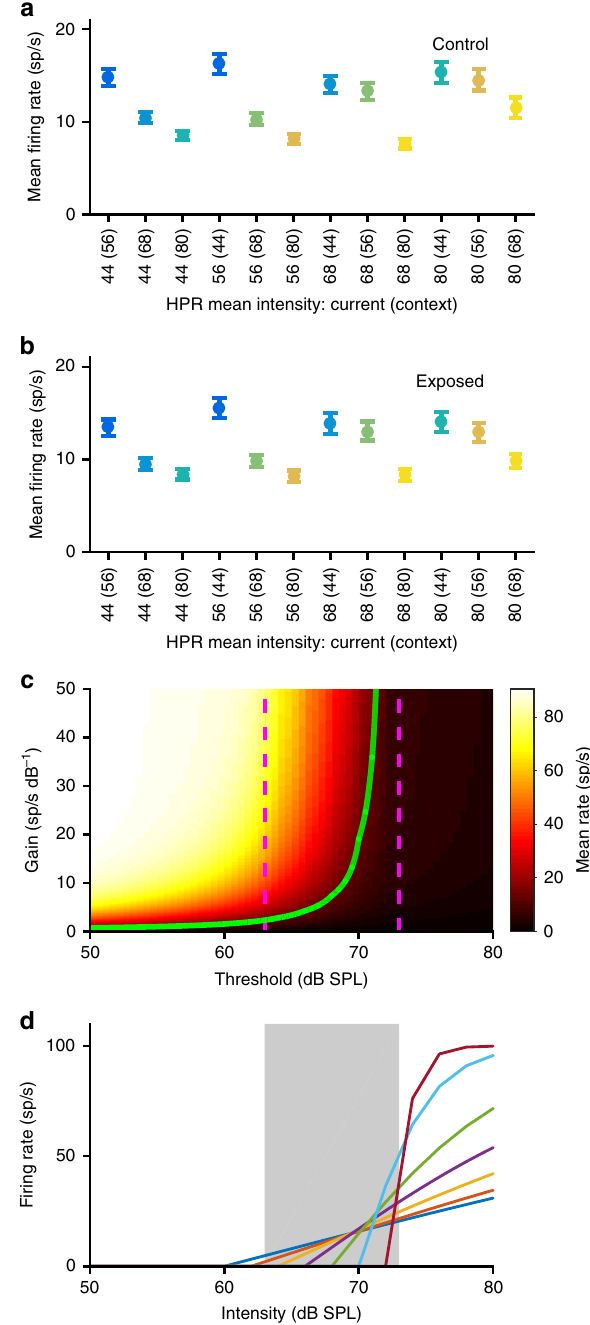
Fig. 5 Constant mean fi ring rates across HPRs and adaptation model. a Mean fi ring rates over the entire duration of each HPR, averaged across all MUCs from control animals. Colour scheme for the HPRs is the same as in Fig. 3. All error bars denote ±s.e.m. b Mean fi ring rates of MUCs from noise-exposed animals. c Mean fi ring rates of a model neuron for a 68 dB HPR stimulus, in dependence upon its RIF threshold and steepness. The magenta dashed lines indicate the intensity range of the HPR, and the green line denotes those combinations of RIF threshold and gain that give a mean rate of 10 sp/s. d Model RIFs with different thresholds, where the steepness of each RIF has been adjusted to yield a mean fi ring rate of 10 sp/s for a stimulus with a 68 dB